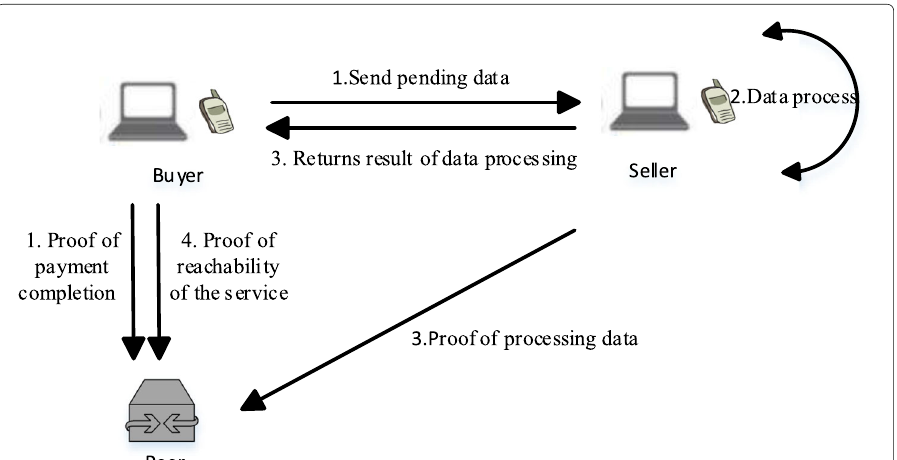
Fig. 6 The mechanism of resources delivery